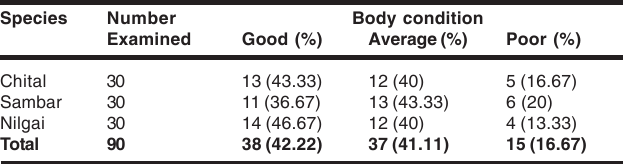
Table 3. Body condition of free ranging